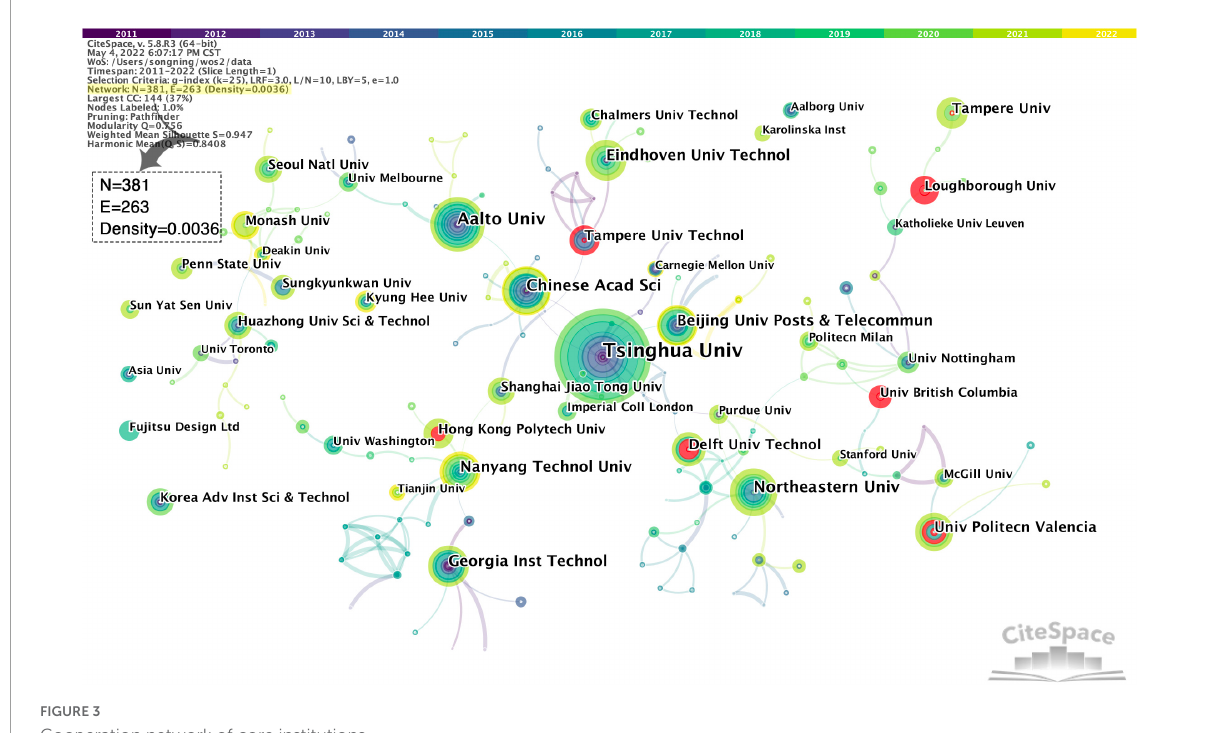
FIGURE3 Cooperation network of core institutions.